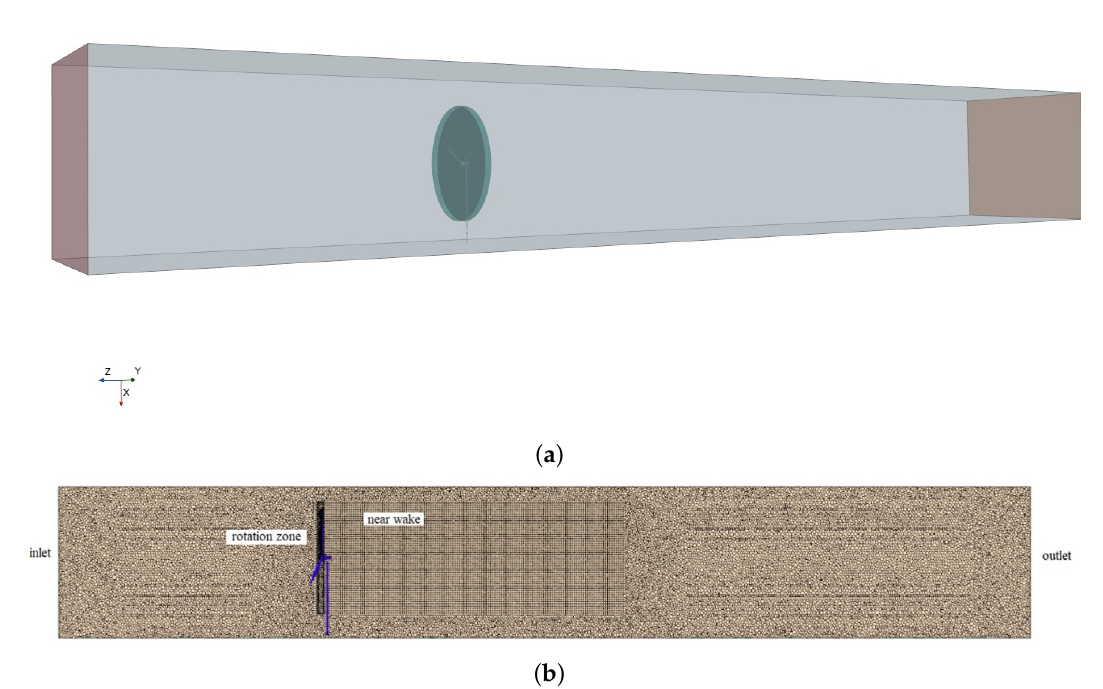
Figure 2. ( a ) Calculation area of the wind generator and ( b ) mesh for modeling a wind turbine. Table 2. Comparison of various meshes and models (wind speed 12.26